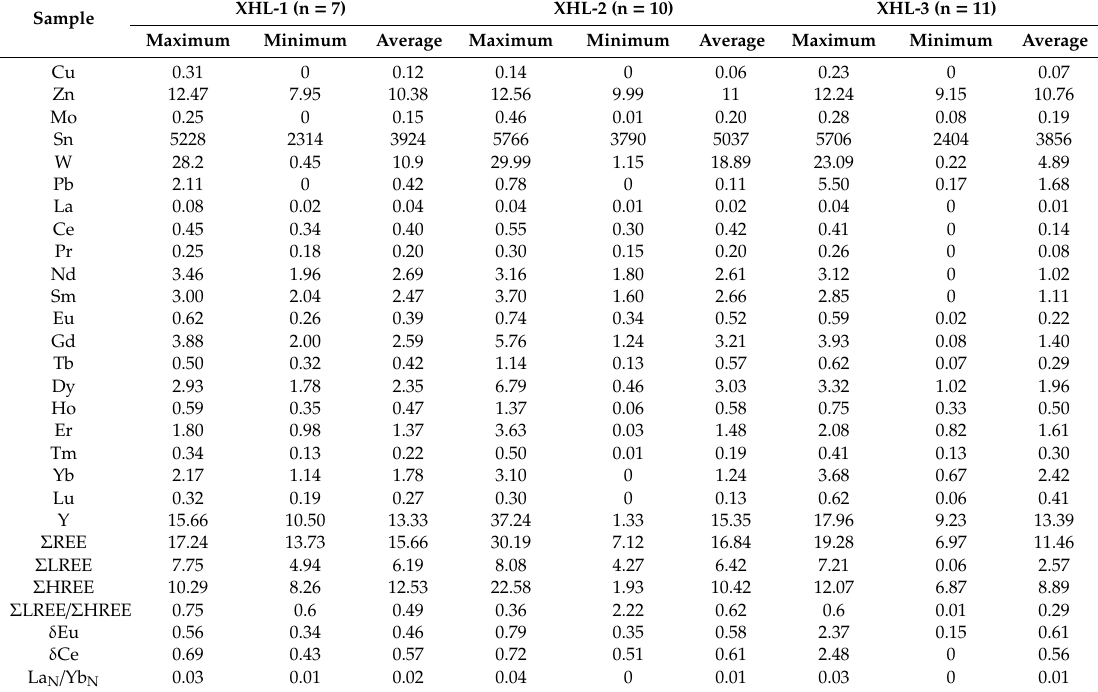
Summary of the compositions (in ppm) for trace and rare earth elements of the Xianghualing